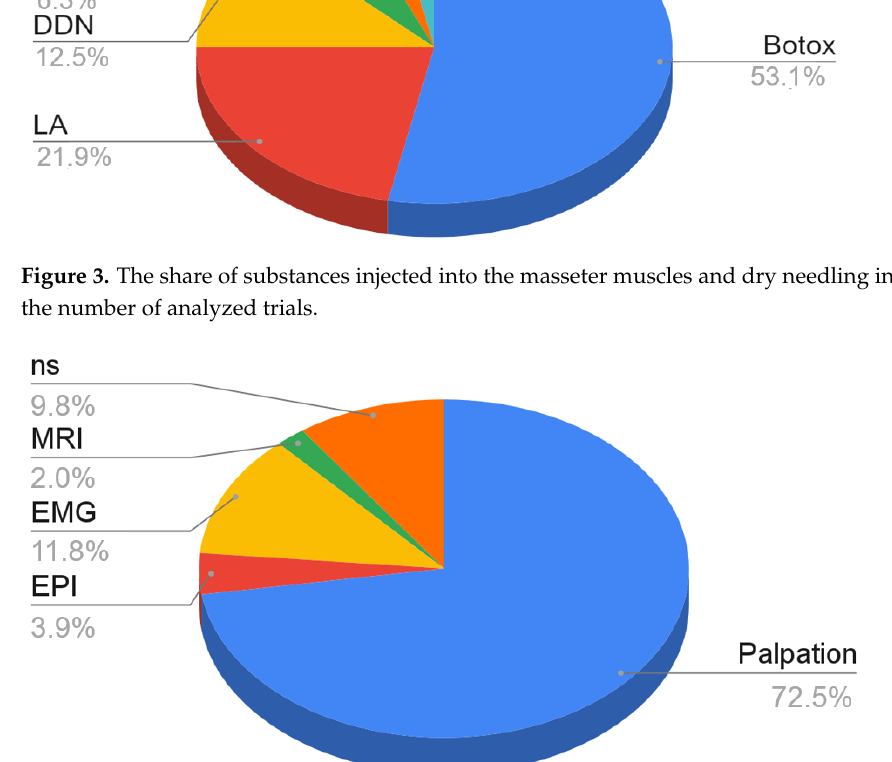
Figure 3. The share of substances injected into the masseter muscles and dry needling in relation to the number of analyzed trials.